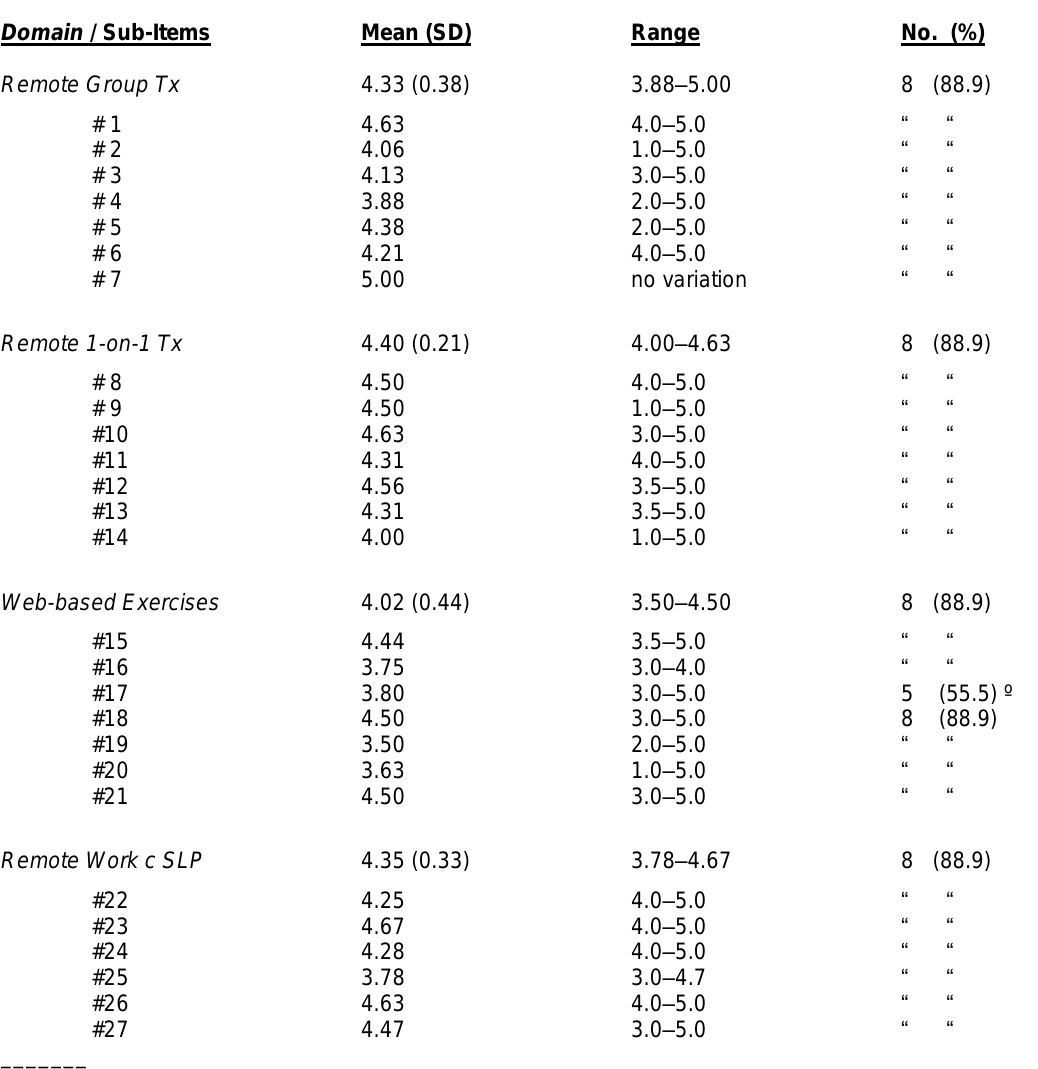
Table 7. User Satisfaction Levels in SCALE Participants with Chronic Aphasia at Conclusion of Remote Therapy and On-line